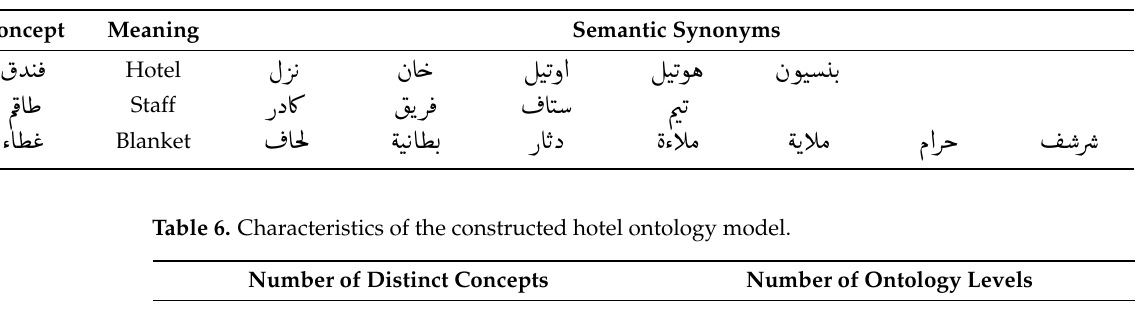
Table 5. Example of semantic synonyms for extracted hotel concepts.